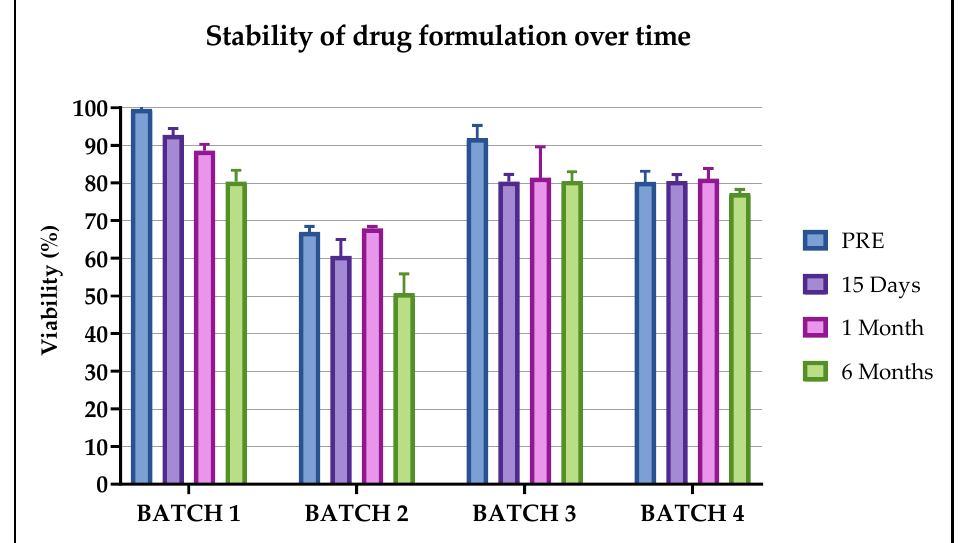
Figure 4. Viability of Batches 1, 2, 3 and 4 evaluated to validate the stability of the cellular product over time. The percentage of viable cells was calculated on fresh product at the time of pre-freezing (PRE) and at different time periods: 15 days, 1 month and 6 months.